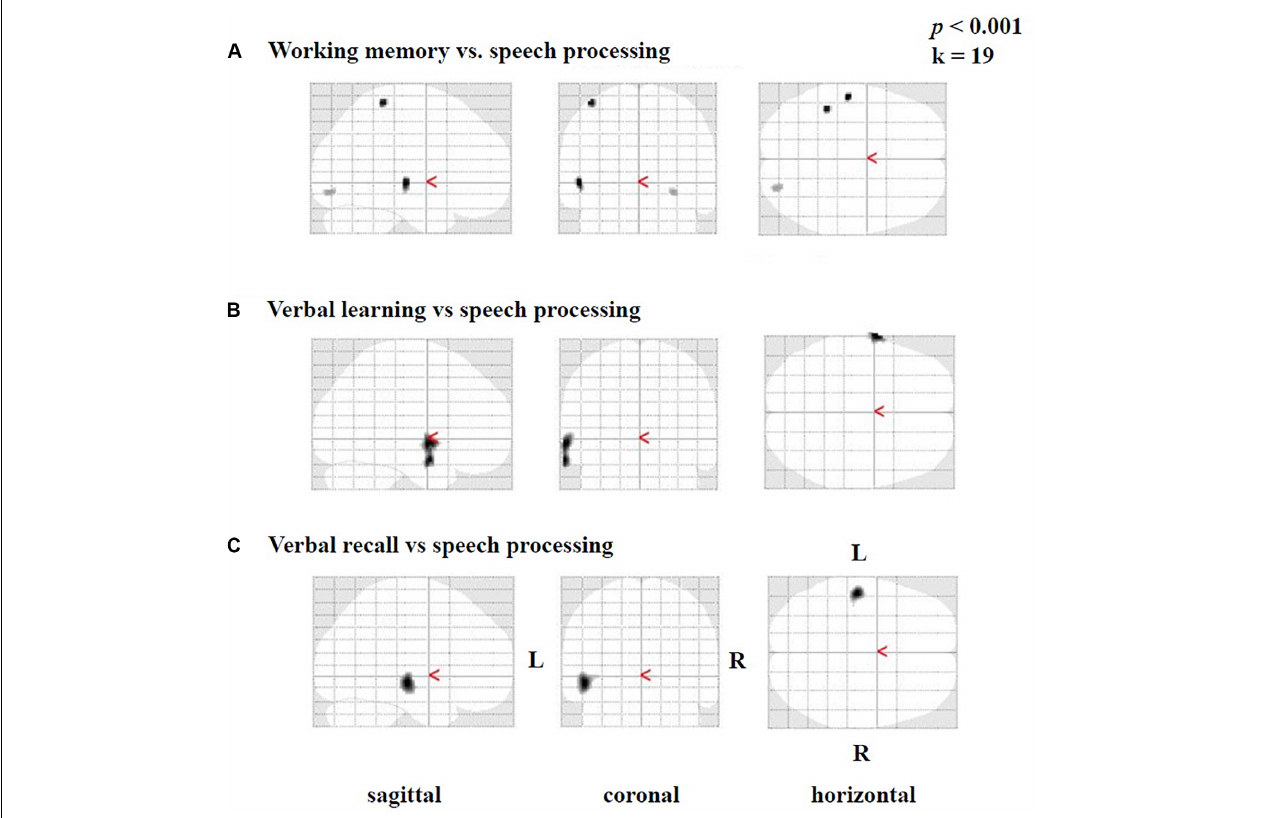
FIGURE 6 | Statistical parametric maps (SPMs) reflecting correlations between activation during the speech-discrimination task (semantic-anomaly paradigm) and cognitive tests, in particular (A) working-memory capacity, (B) verbal learning and (C) verbal recall. Note vastly predominant left temporal correlations for all three